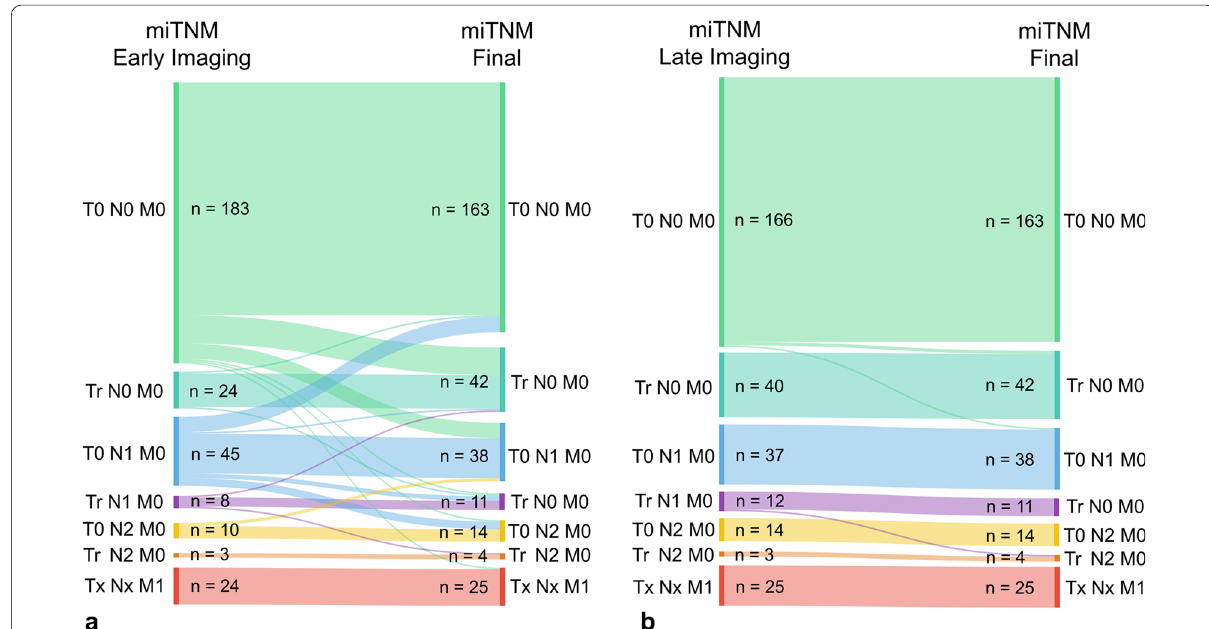
Fig. 4 Sankey diagrams of the miTNM staging differences of early [68 Ga]Ga-PSMA-I&T PET/CT versus the final miTNM staging ( a ) and of late [68 Ga]Ga-PSMA-I&T PSMA PET/CT versus the final miTNM staging ( b ). The number of changes is depicted by the strength of lines connecting the respective miTNM